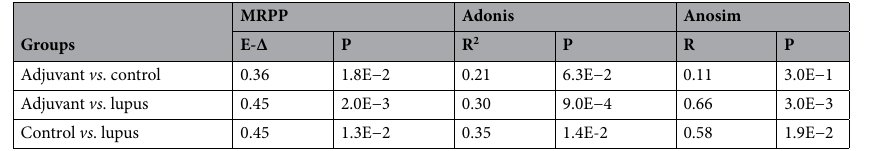
Table 1. Statistical differences in microbial community structure between two groups. Three different tests were performed using MRPP, Adonis, and Anosim and were based on the Bray–Curtis dissimilarity index. E-Δ, expected-delta.